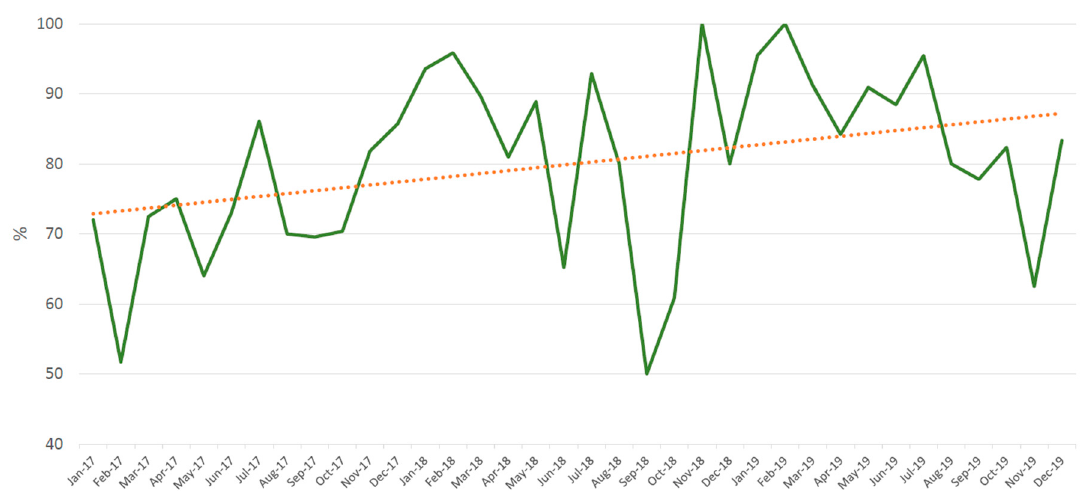
Figure 1. Percentage of optimal prescriptions during the postintervention period (2017–2019) in patients admitted due to appendix-related intraabdominal infections (AR-IAIs). Overall, 715 prescriptions were evaluated and a trend towards an improvement was observed ( p = 0.052).